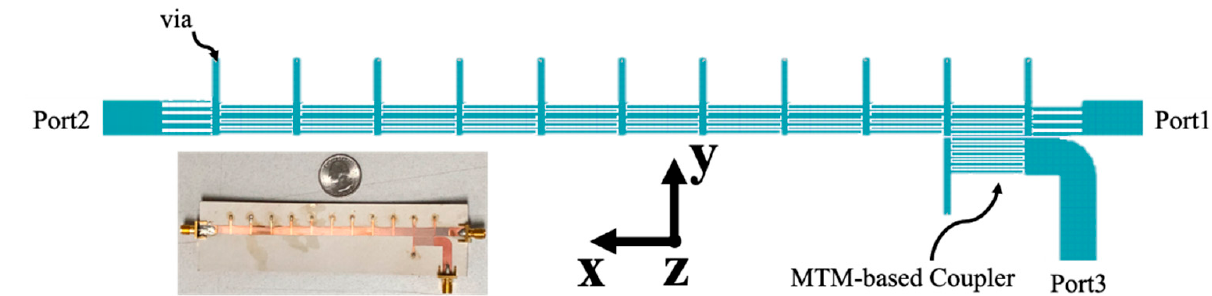
Figure 14. Layout and prototype of 1-D MTM LWA at 2.4 GHz.